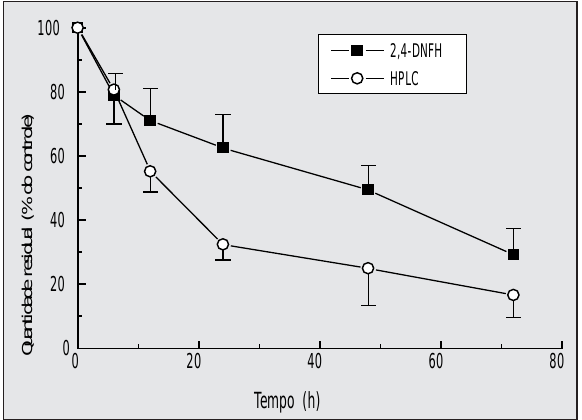
Figura 5 – Estabilidade do ácido ascórbico em soro. Quantidades crescentes de ácido ascórbico (concentração final: 0,5 a 40mg/dl) foram adicionadas em pool de soro